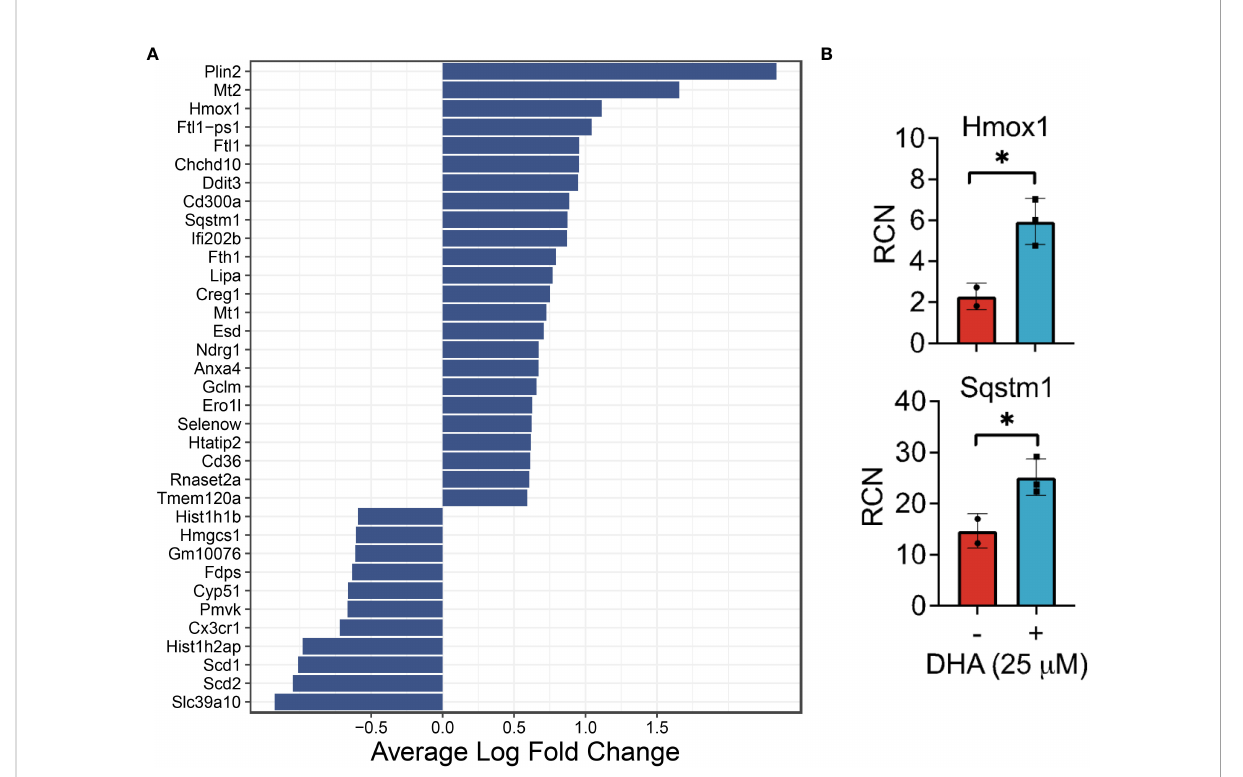
FIGURE 4 DHA in fl uences expression of genes in FLMs involved in lipid uptake/metabolism ( Cd36, Plin2, Lipa ), antioxidant response ( Sqstm1, Hmox1, Chchd10) , metal homeostasis ( Mt1, Mt2, Ftl1, Fth1) and immune regulation ( I fi 202b, Cd300a, Anxa4 ) at 0h. (A) Differentially expressed genes were identi fi ed using the Seurat FindMarkers function, with thresholds set to select genes with >1.5-fold change (Adjusted p -value < 0.001) in gene expression and genes expressed in at least half in the Veh.LPS.0 or DHA.LPS.0 groups. (B) Expression of Hmox1 and Sqstm1 , two genes induced by DHA treatment, was con fi rmed using bulk qPCR of samples treated in parallel with treatments for single cell isolation. Asterisks indicated signi fi cant differences * p< 0.05) between Veh (-) and DHA (+) groups, as assessed by Student ’ s